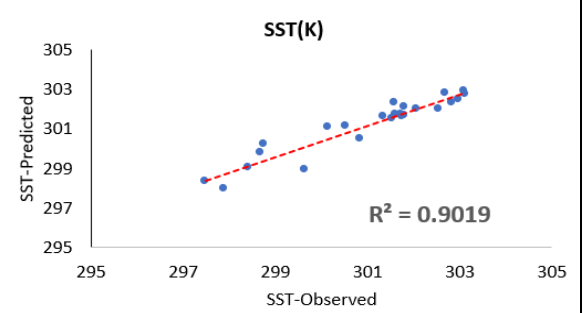
Figure 8. Trend in SST for the period 1990 to 2040 3.3